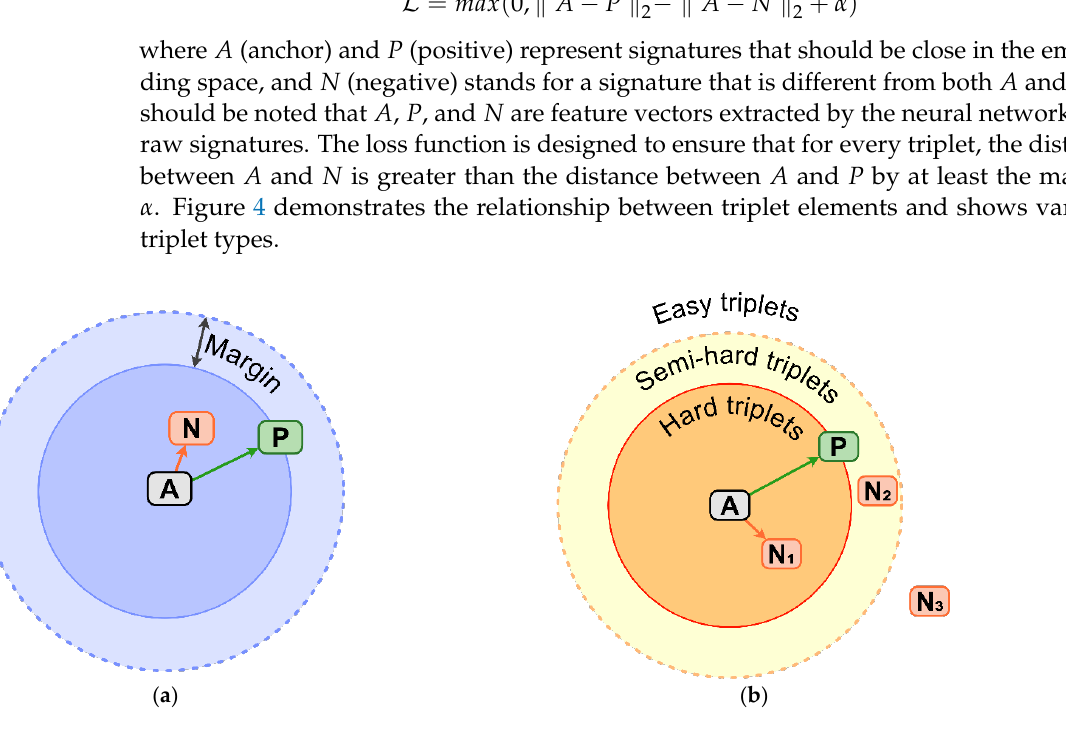
Figure 4. Diagram ( a ) demonstrates a triplet violating the triplet loss condition. 𝐴 (anchor) and 𝑃 (positive) represent feature vectors of similar signatures, and 𝑁 (negative) represents feature vectors of a signature different from both 𝐴 and 𝑃 . The triplet loss algorithm aims to ensure that the distance from 𝐴 to 𝑁 ( 𝐴𝑁 distance) is greater than the 𝐴𝑃 distance for every triplet, at least by the margin. Diagram ( b ) illustrates three possible types of triplets, depending on the distance between 𝐴 and 𝑁 points.